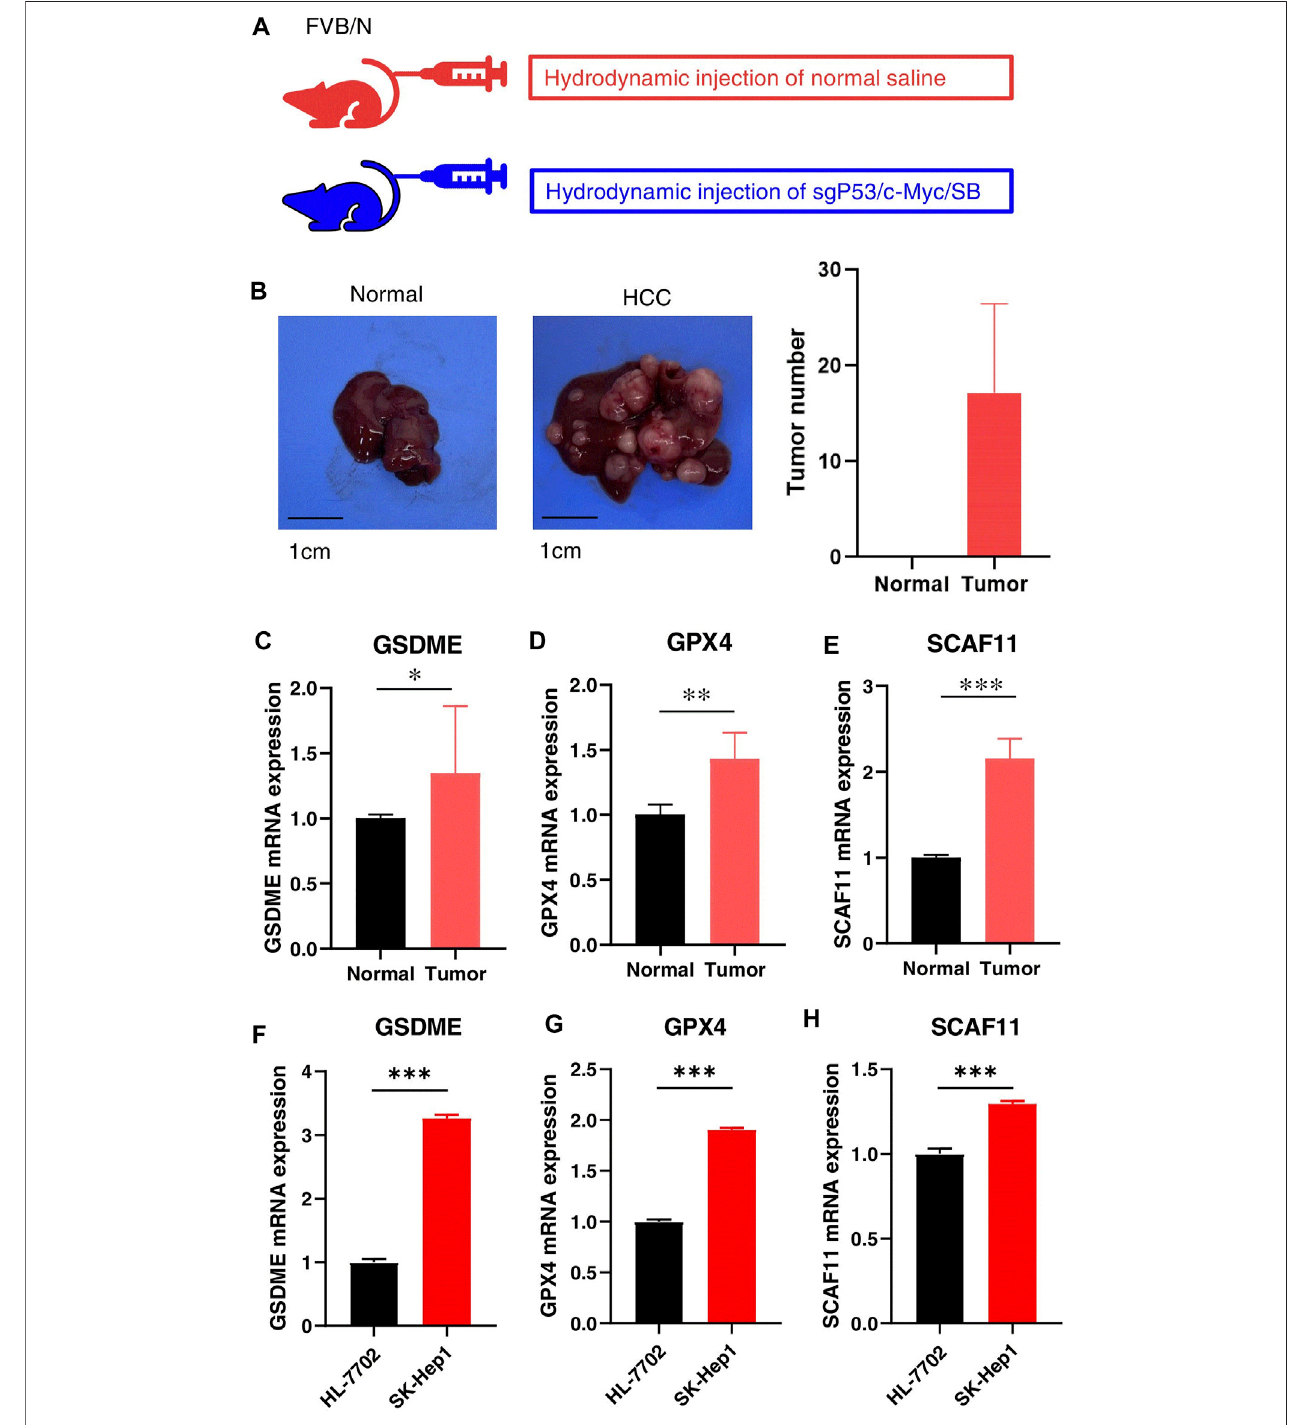
FIGURE 10 | Validation of the independent prognostic genes in vivo and in vitro . (A) HCC Model design. FVB mice were injected with normal saline or sgP53/ c-Myc/SB plasmids, respectively. (B) Representative liver tissues of normal (left) and HCC mice (middle) and tumor numbers (right). (C – E) The mRNA expressions of GSDME, GPX4, and SCAF11 in the normal and HCC livers. (F – H) The mRNA expressions of GSDME, GPX4, and SCAF11 in the human normal liver cell HL-7701 and liver cancer cell SK-Hep1. * p < 0.05, ** p < 0.01, *** p < 0.001.